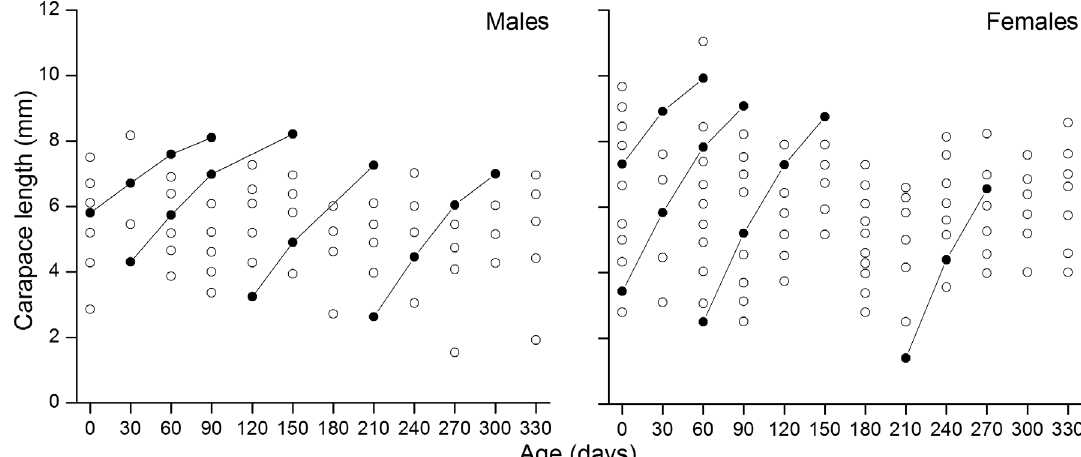
Figure 7. Modal dispersion and selected cohorts for males and females of Palaemon pandaliformis collected from September 2009 and August 2010 in Rio Salsa, Canavieiras, Bahia, Brazil.